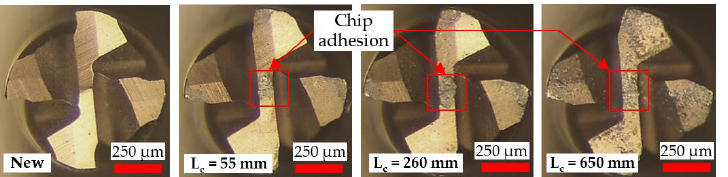
Figure 13. Micrographs of tool wear progression in Test 5. v f = 25 mm/min, f z = 0.156 µm/tooth.